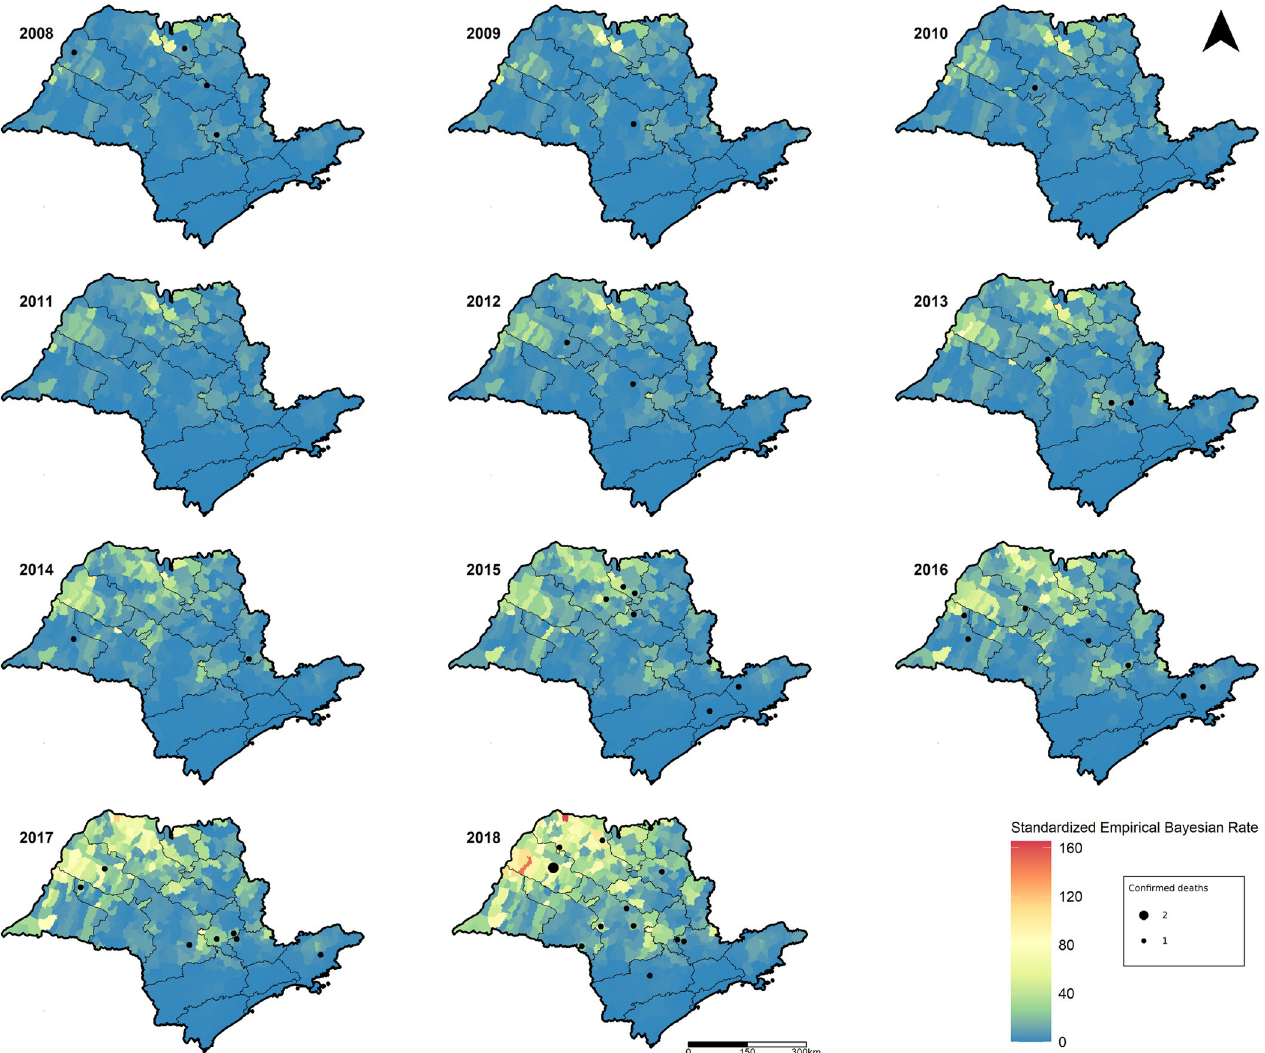
Fig 3. Maps of standardized local empirical Bayesian incidence rates (per 10,000 inhabitant-years) and deaths from scorpion envenomations for municipalities in the state of S ã o Paulo, Brazil from 2008–2018.